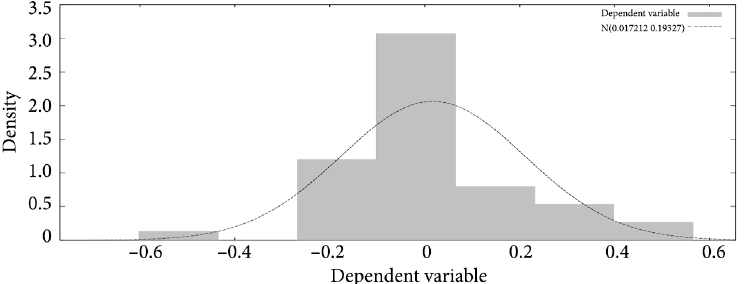
Figure 4. The normality of the residual test for the 2 nd model (source: GRETL